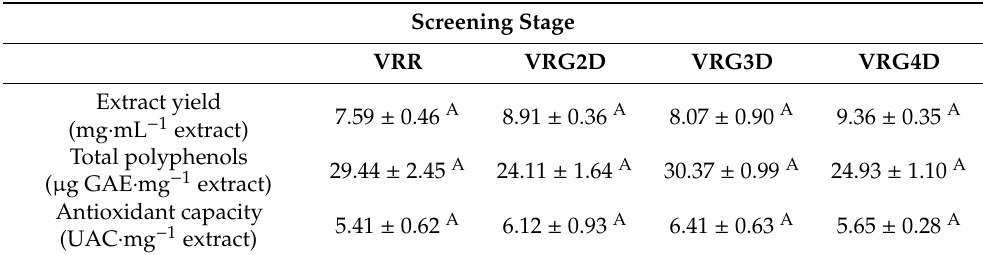
Table 2. E ff ect of di ff erent germination periods on the total polyphenol content and antioxidant properties of mung bean